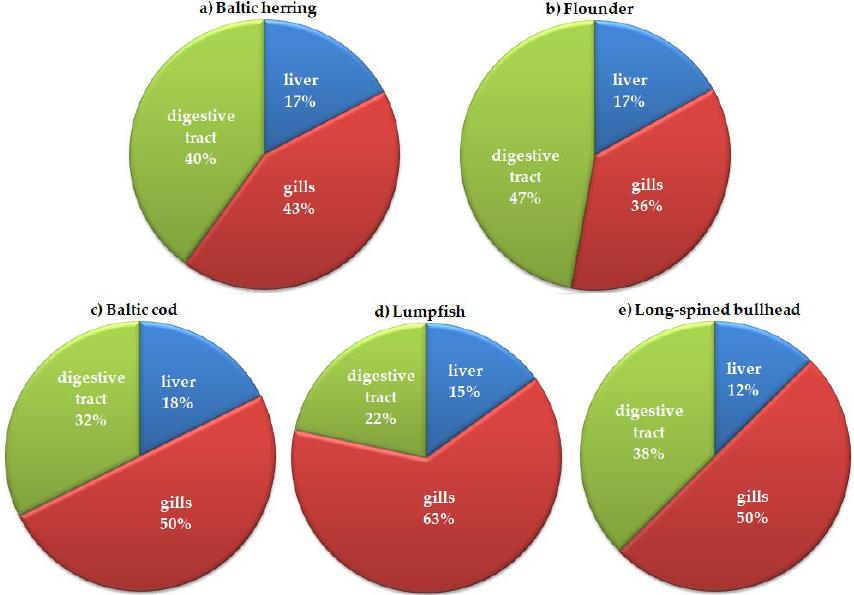
Figure 3. Percentage contribution of the numbers of MPs identified in the organs of fivefish species caught for commercial purposes and as by-catch in 108 and 103 FAO areas in the southern Baltic Sea.